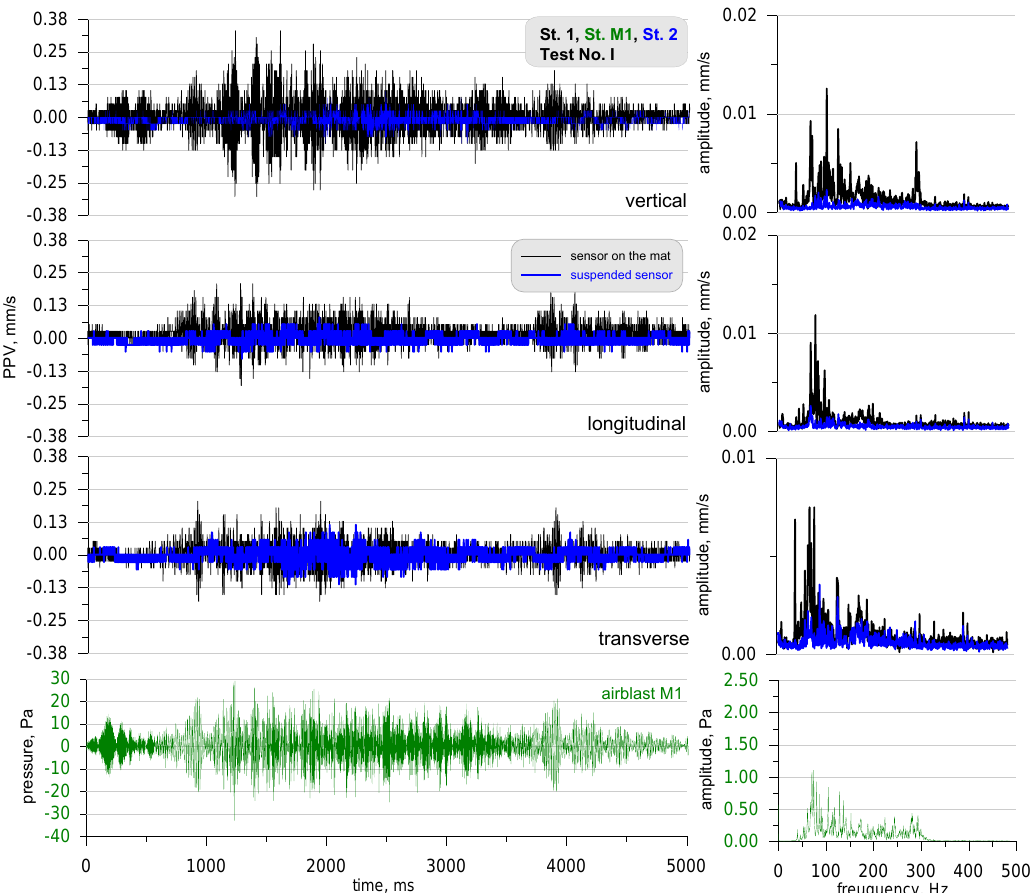
Figure 6. Test No. I: Vibration seismogram (three directional components) and airblast pressure record with FFT analysis – sine sweep in range 30-300 Hz – stand 1 and 2.